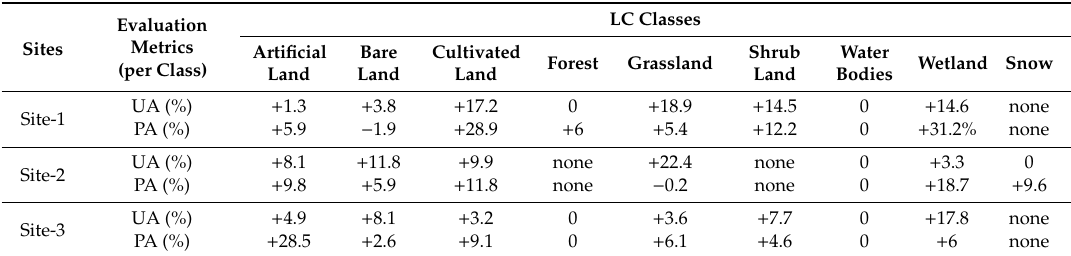
Table 3. Effects of the Scenario- 4 on User’s Accuracy (UA) and Producer’s Accuracy (PA) values over three experiment sites. The increased and decreased in the accuracies are indicated by + and − signs, respectively (refer to Appendix B for more detailed information).